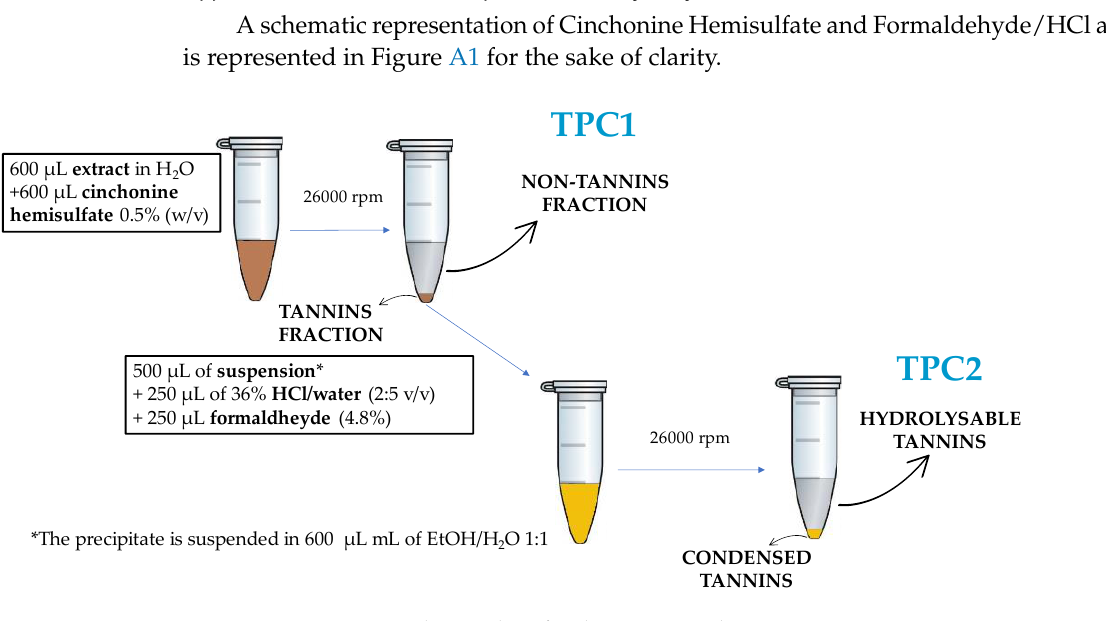
Figure A1. Experimental procedure for the tannin analyses.